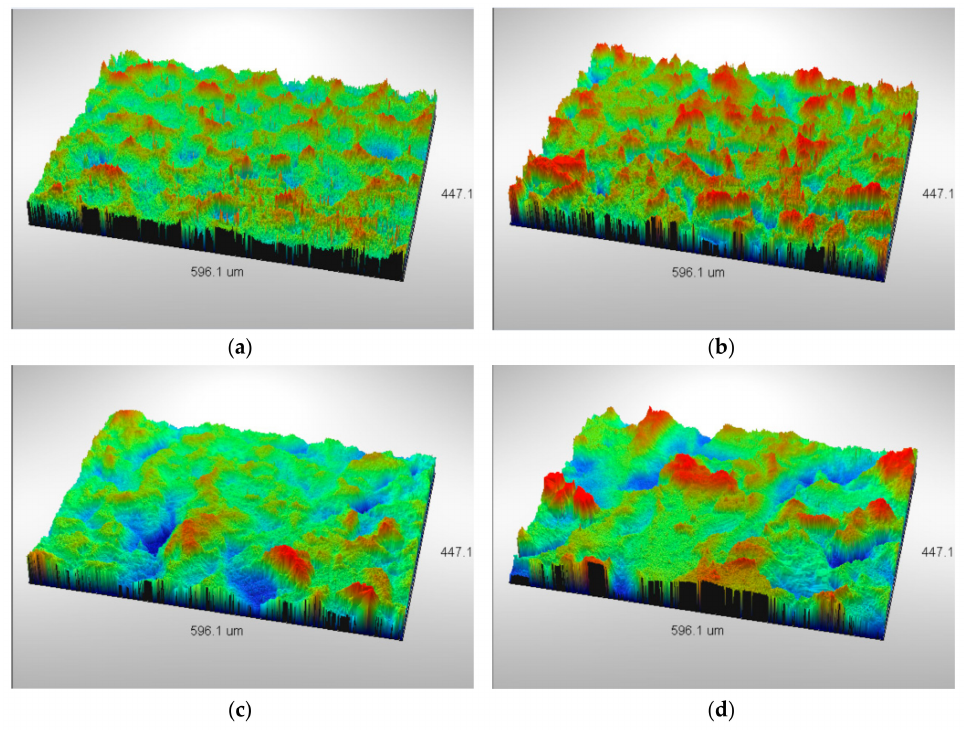
Figure 4. Surface roughness images of CR980 conducted by sandblast: ( a ) Rz = 20 µ m; ( b ) Rz = 35 µ m; ( c ) Rz = 45 µ m; ( d ) Rz = 60 µ m.